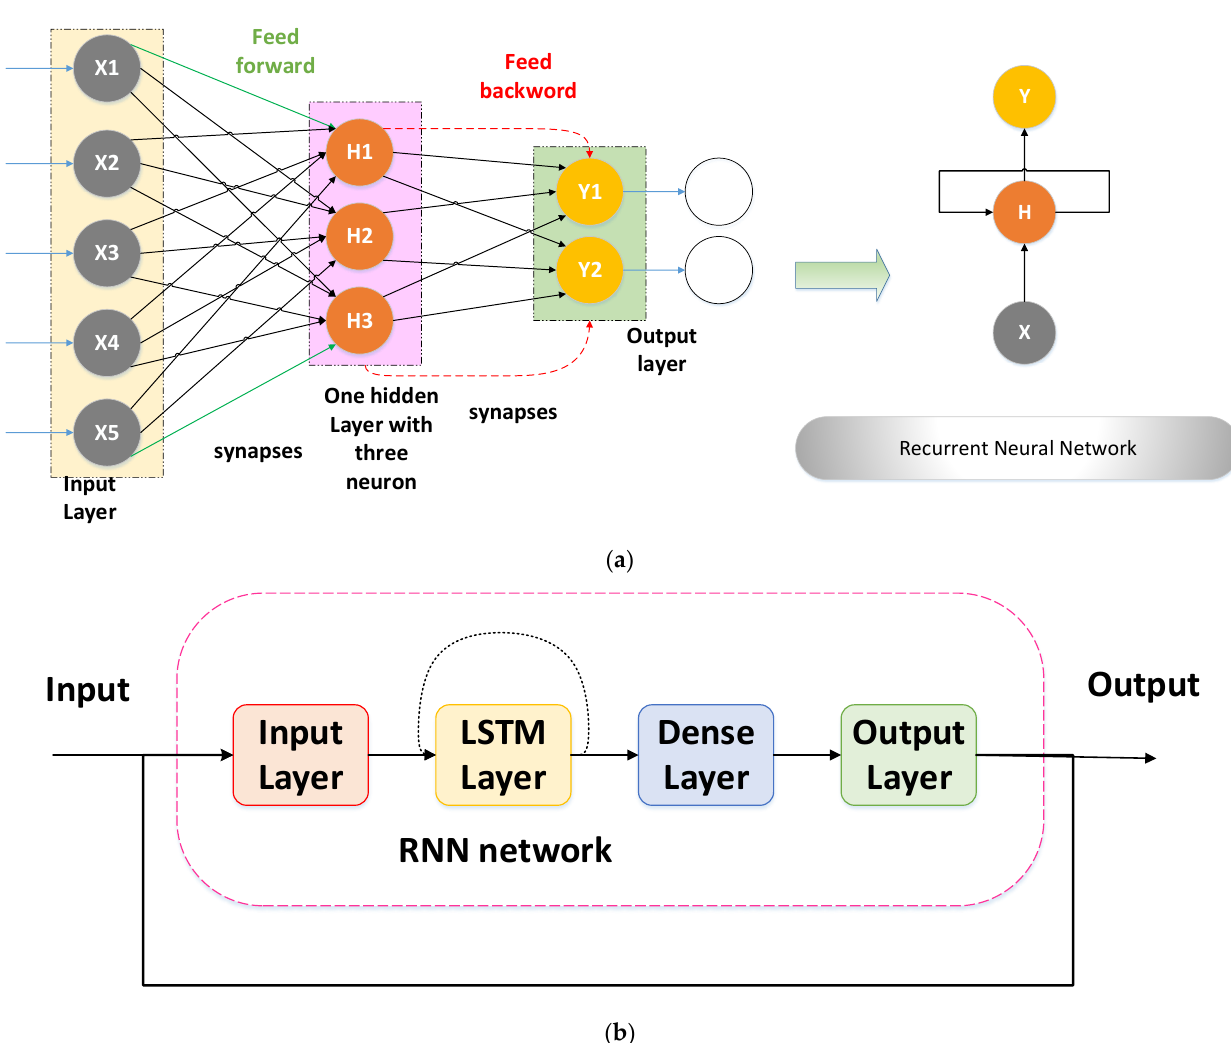
Figure 2. ( a ) Standard infrastructure of typical RNN. ( b ) Workflow of